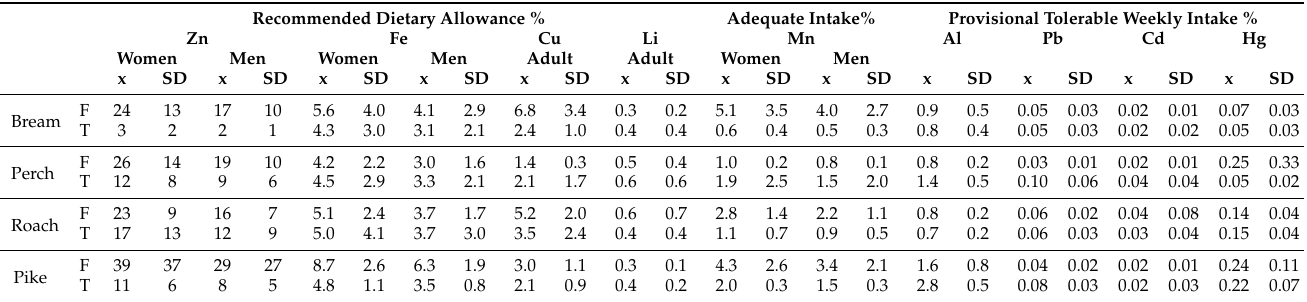
Table 6. Coverage of the daily requirement for micronutrients (%) and the degree of risk resulting from the intake of toxic elements with a portion of fish gonads (%